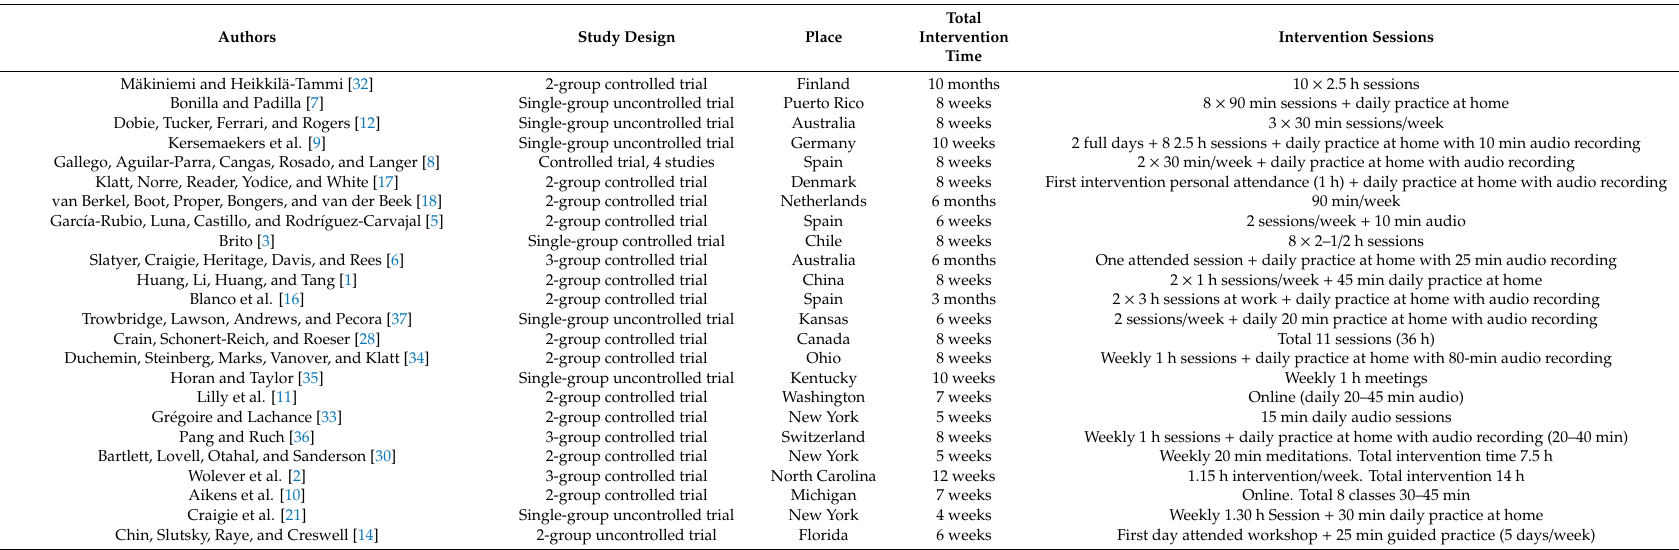
Table 1. Studies dealing with the relationship between mindfulness and